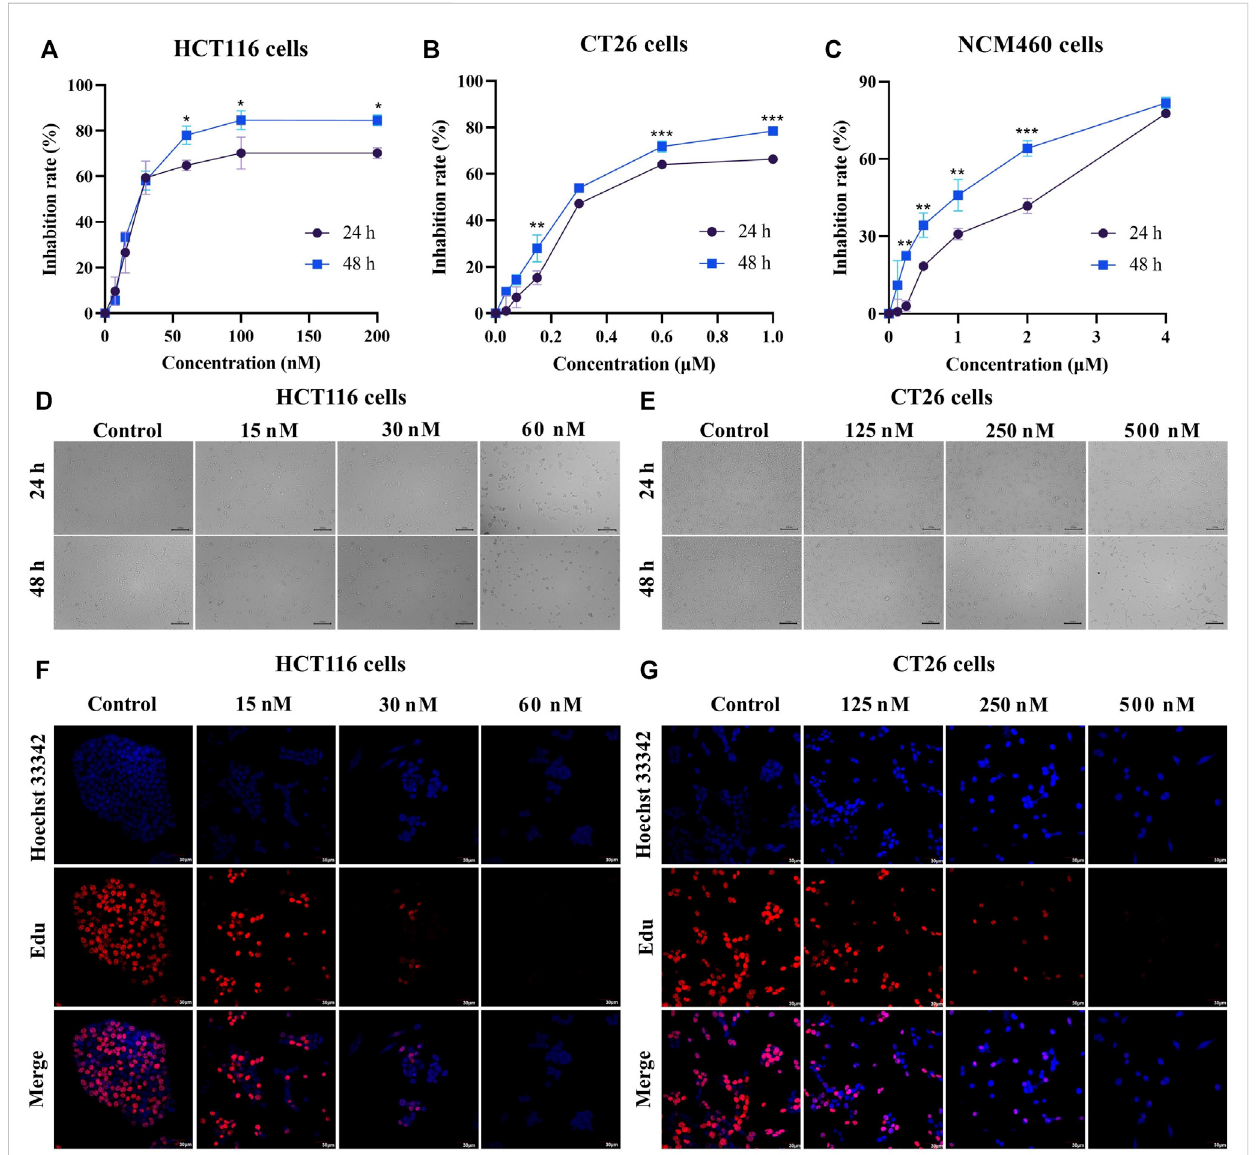
FIGURE 3 BA inhibited cell proliferation in HCT116 and CT26 cells. (A – C) The cell inhibition rate of HCT116 (A) , CT26 (B) and NCM460 (C) cells were treated with different concentrations of BA for 24 h or 48 h (D,E) The morphological changes of HCT116 (D) and CT26 (E) cells treated with BA for 24 h or 48 h (F,G) Representative images of Edu-labeled HCT116 (F) and CT26 (G) cells after 48 h of BA treatment. Red: Edu, Blue: Hoechst 33,324. * p < 0.05, ** p < 0.01, *** p < 0.001, compared to the 24 h